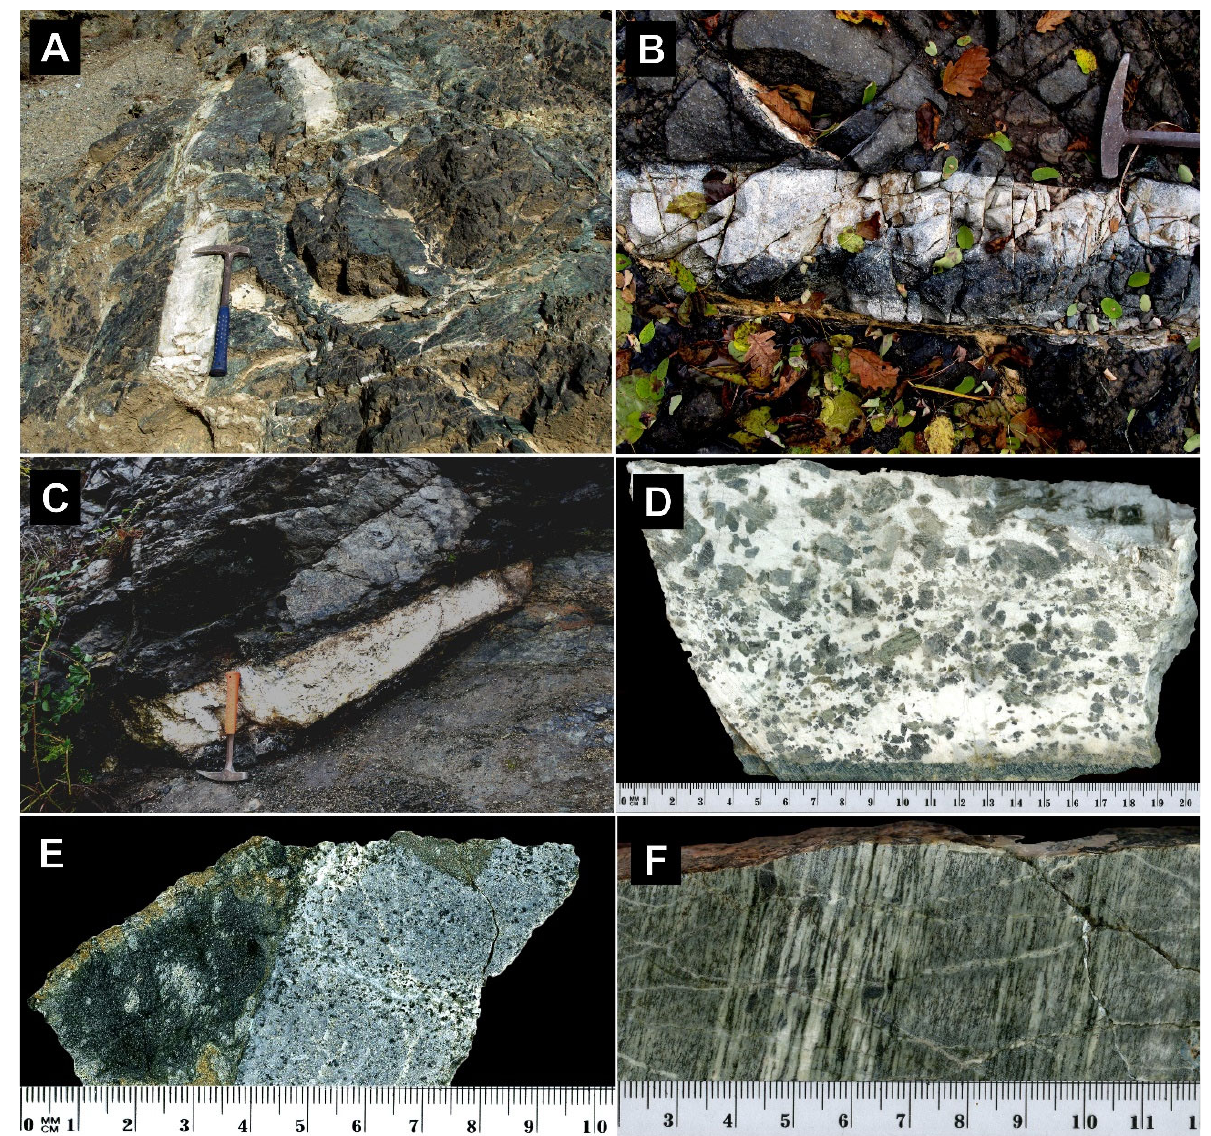
Figure 14. Gabbro dykes in peridotite. ( A ) Mylonitized Cpx ‐ Pl gabbro dyke (P23A) in host serpentinized harzburgite. ( B ) Plagioclase ‐ rich gabbro dyke (pale, P19A1) intruded a dunitic layer (dark, P19A2) within the host harzburgite . ( C ) Boudinaged gabbro ‐ pegmatite (P29C1) dyke in harzburgite. ( D ) Cut surface of gabbro ‐ pegmatite (P29C1) shows Cpx and Pl grain ‐ size reduction towards interface with the harzburgite host (P29C2) at the bottom. ( E ) Cut surface of micro ‐ gabbro dyke (P29A1) in harzburgite (P29A2) with a cm ‐ size xenolith of the host peridotite (on the top). ( F ) Cut surface of Cpx ‐ Pl gabbro mylonite (P23A) with rotated σ‐ type Cpx porphyroclasts in the mylonitic banded structure.